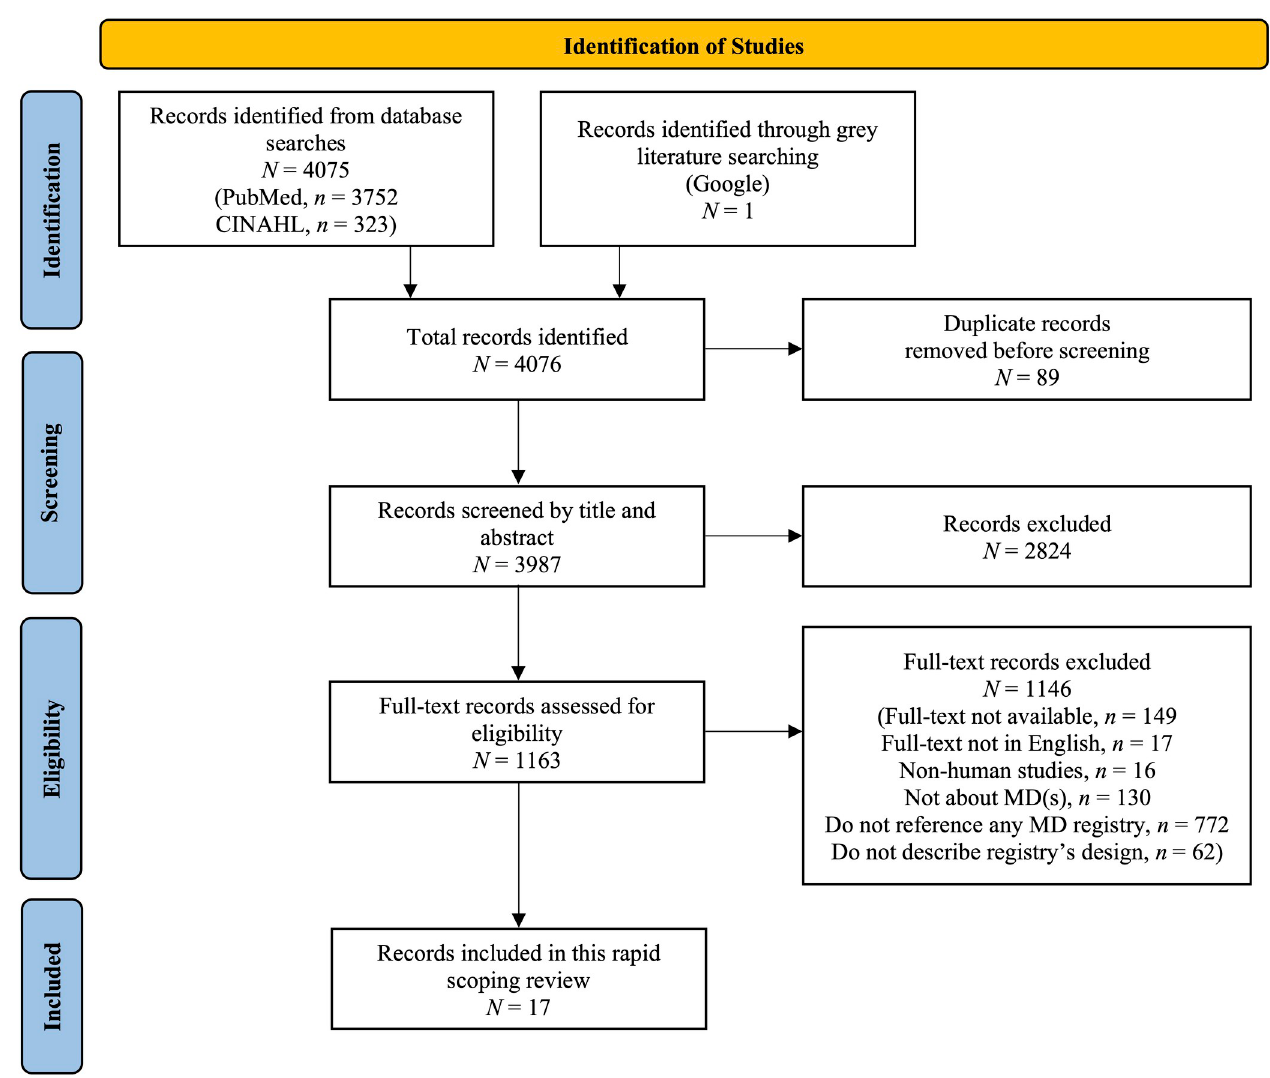
Fig 1. PRISMA flow diagram for study inclusion. This diagram was adapted from Page et al. [25]. MD: Mitochondrial disease.